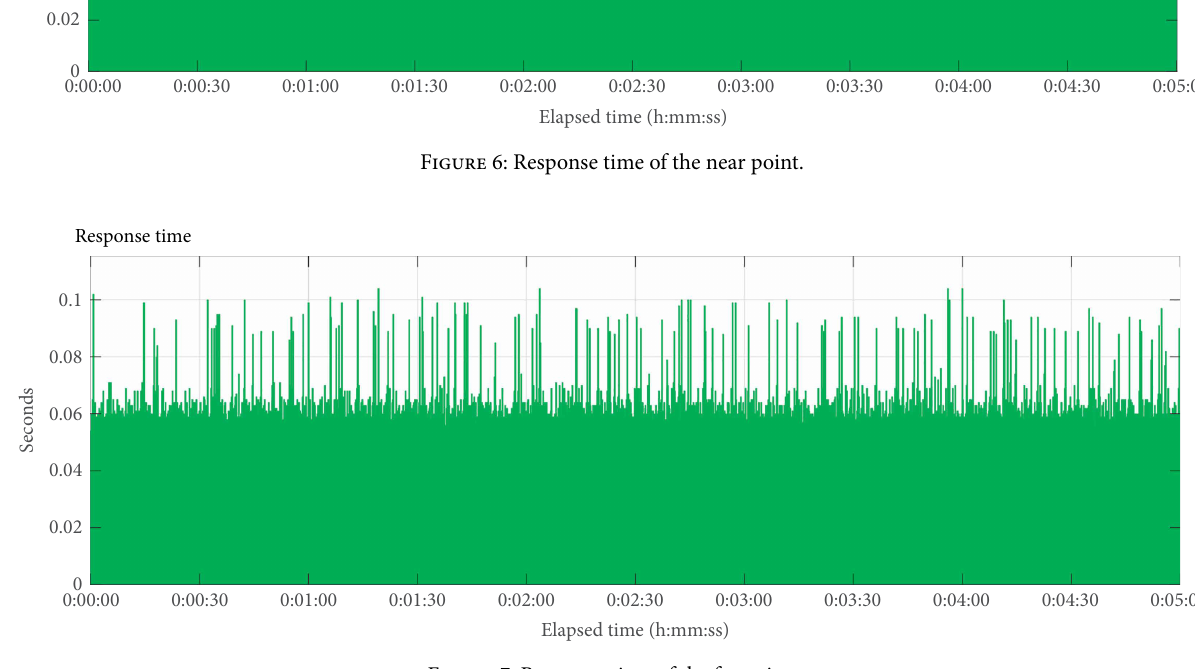
Figure 7: Response time of the far point.